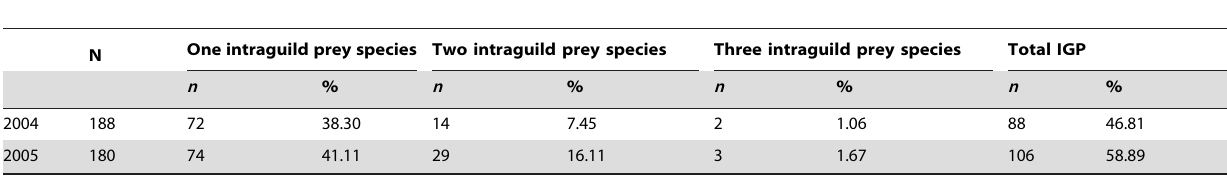
Table 1. Number (N) of specimens tested and levels of intraguild predation (raw data) among four coccinellid species with molecular gut-content detection of one to three different intraguild prey species in a same predator, in 2004 and 2005.